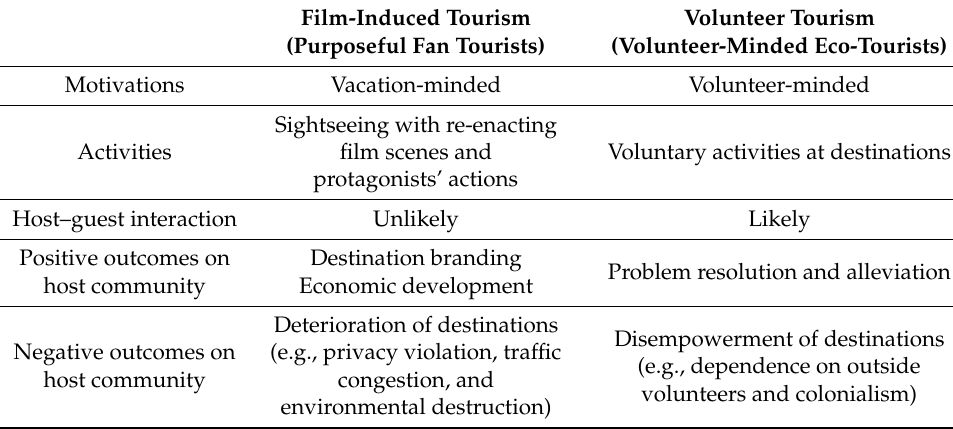
Table 1. Differences between film tourism and volunteer